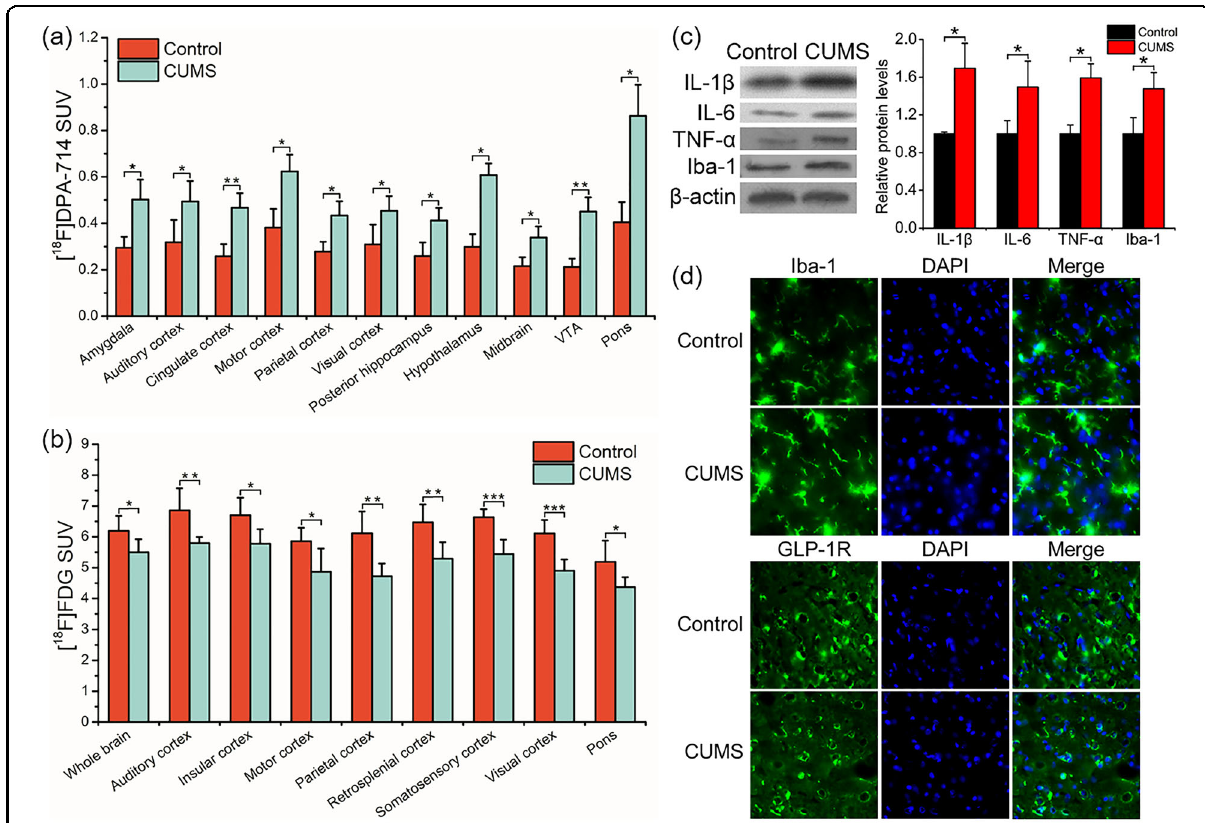
Fig. 3 Multimodal assessment of CUMS-induced depressive rats. The [ 18 F]DPA-714 uptake quanti fi cation in 11 ROIs ( a ) and the [ 18 F]FDG uptake quanti fi cation in 9 ROIs ( b ) of the brain which showed signi fi cant differences between control group and CUMS group. c Western blot analysis of IL-1 β , IL-6, TNF- α , and Iba-1 in hippocampus of normal rats and CUMS rats. d Immuno fl uorescence staining of hippocampal sections from normal rats and CUMS rats. * p < 0.05; ** p < 0.01; *** p < 0.001. VTA ventral tegmental area. n = 12/group for PET imaging ( a , b ). n = 3 for western blot and immuno fl uorescence ( c , d